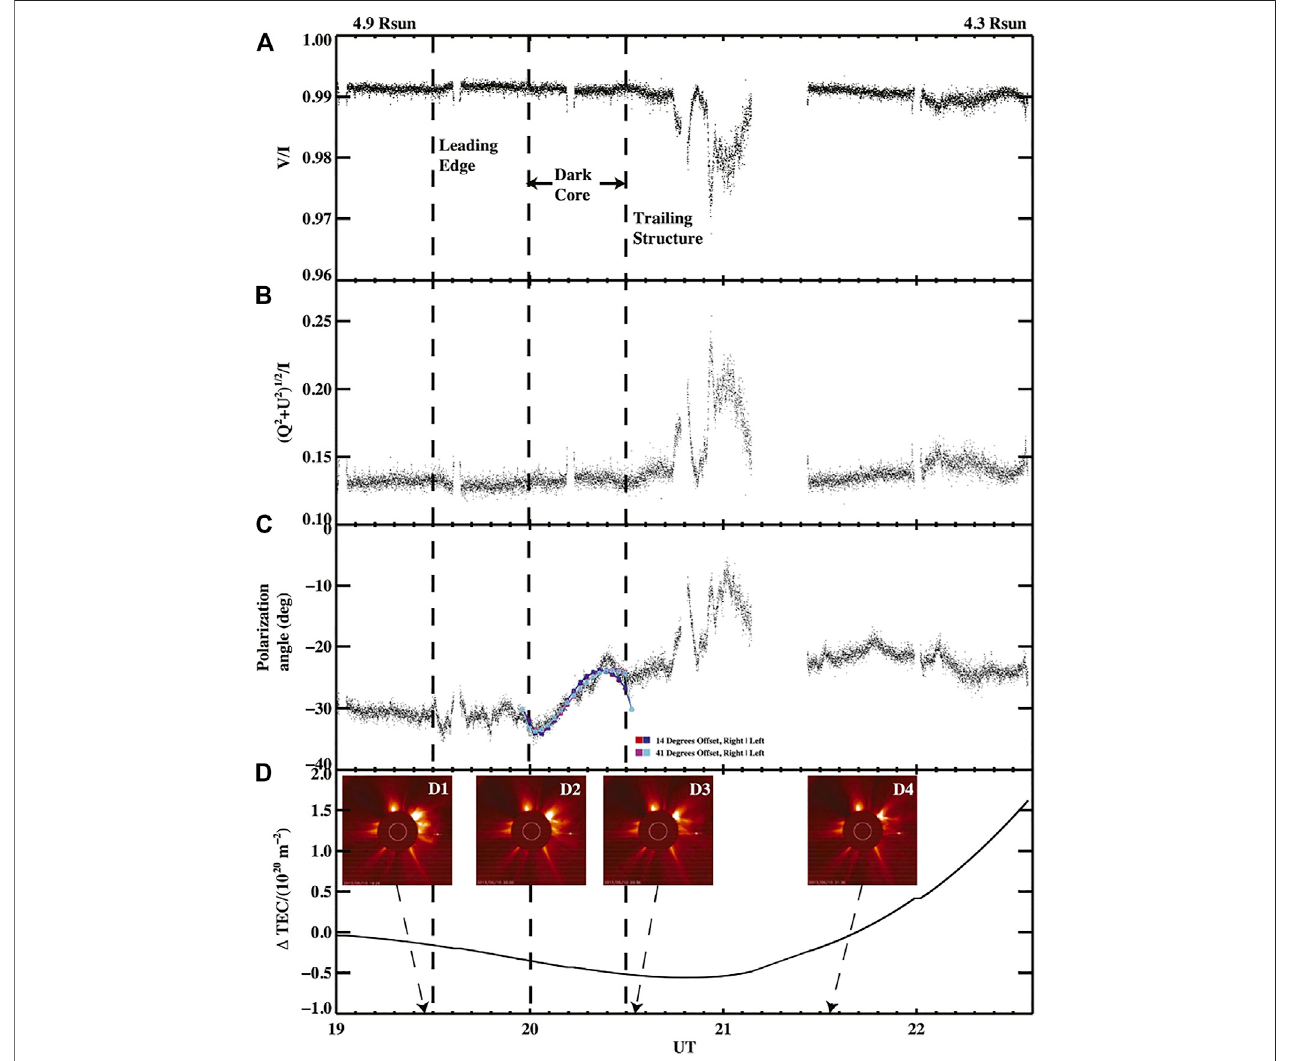
FIGURE7| ObservationsofCMEFRusingaspacecraftasthebackgroundradiosource.Panels (A) and (B) arethefractionalcircularandlinearpolarizationsofthe MESSENGER signal,respectively;panel (C) isthepolarizationangleshowingtheFR, withforce-free magnetic fl uxrope fi tstothe “ DarkCore ” areoverlaidincolor; panel (D) isthechangeinTECasdeterminedfromtheapparent-Dopplertrackingmethod( Section3.3 ).White-lightimagesfrom SOHO LASCO-C2atthetimeperiodsshown are provided. Range in R 0 is shown at the top. These data correspond to values reported for 2013 May 10 g in Table 3 . This appears as Figure 2 in Jensen et al. (2018), ©AAS, reproduced with